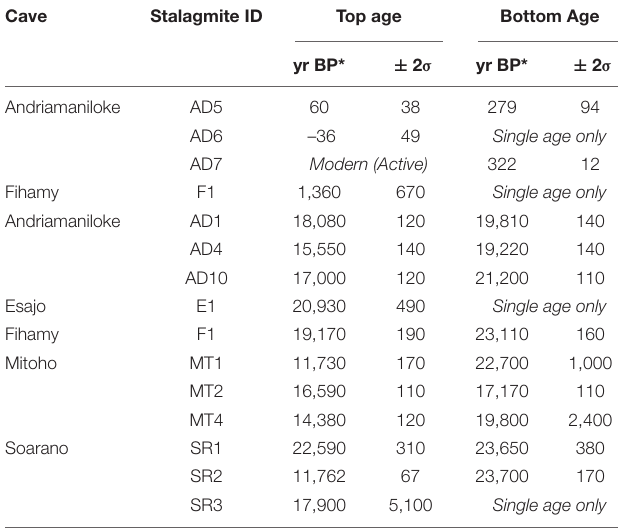
TABLE 1 | Youngest and oldest age determinations for Tsimanampesotse stalagmites that cover the Last Glacial Maximum (which peaked between 22,900 and 19,400 yr BP), the last deglaciation, and the Holocene (beginning 11,700 yr